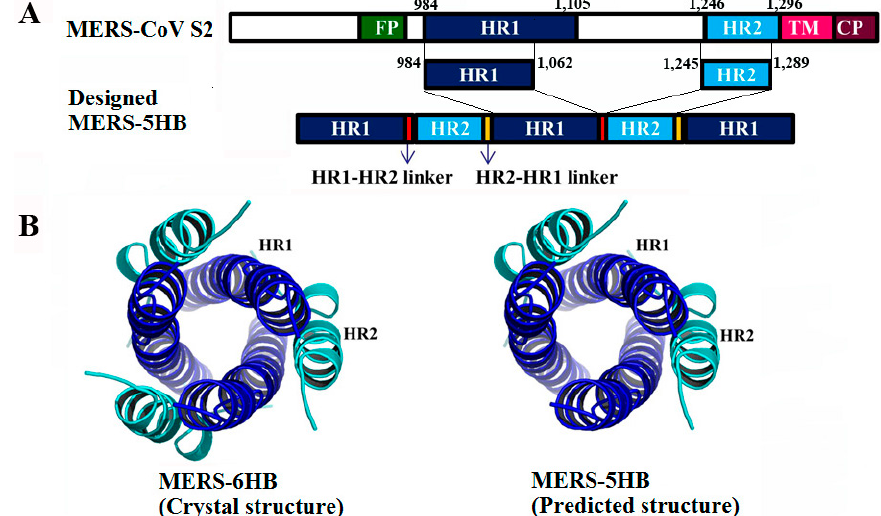
Figure 1. Design of the MERS-five-helix bundle (MERS-5HB) inhibitor. ( A ) Schematic representation of MERS-5HB based on the Middle East respiratory syndrome coronavirus (MERS-CoV) (S2) subunit. Heptad repeat 1 (HR1) (residues 984 to 1062) and heptad repeat 2 (HR2) (residues 1245 to 1289) are from the major parts of HR1 (residues 984 to 1105) and HR2 (residues 1246 to 1296) domains in the S2 subunit. MERS-5HB contains three HR1 segments and two HR2 segments. The linker of HR1 to HR2 is SGGRGG and the linker of HR2 to HR1 is GGSGGSGG. ( B ) Models of the MERS-CoV fusion core (MERS-6HB) (PDB: 4MOD [10]) ( left ) and MERS-5HB ( right ). As a solved crystal structure, the six-helix bundle contains three HR1 segments (shown in blue) which form a central core, and three HR2 segments (shown in cyan) which pack into the HR1 side grooves.